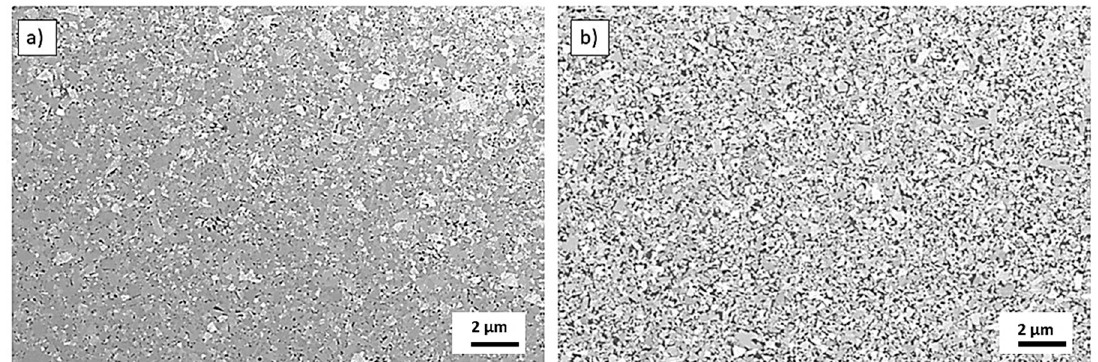
Figure 15. FESEM micrographs of the substrate: ( a ) SH-5; ( b ) SH-15.